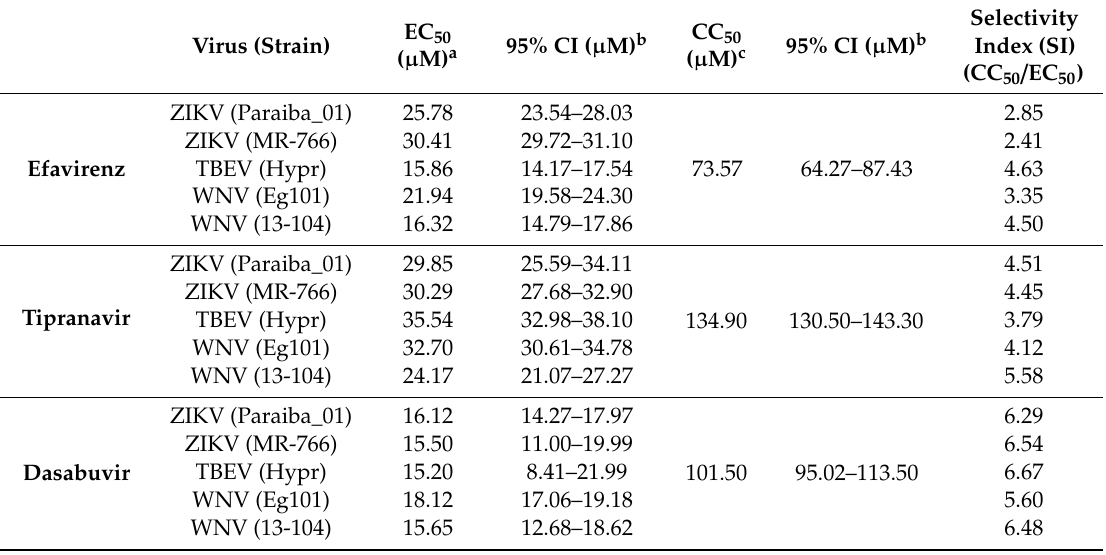
Table 2. Virus inhibition and cytotoxicity characteristics of efavirenz, tipranavir, and dasabuvir in Vero cells.